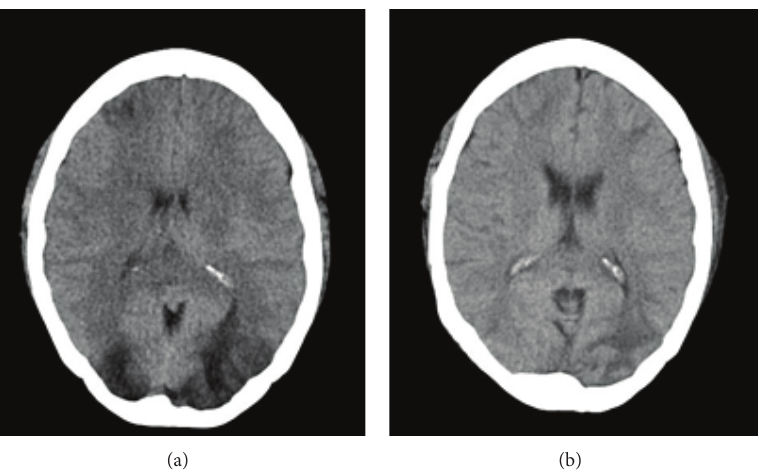
Figure 1: (a) Brain CT scan showing hypodense lesions in subcortical white matter of frontal and occipital lobes. (b) Brain CT 8 days after initiation of neurological symptoms, showing significant reduction of previously described